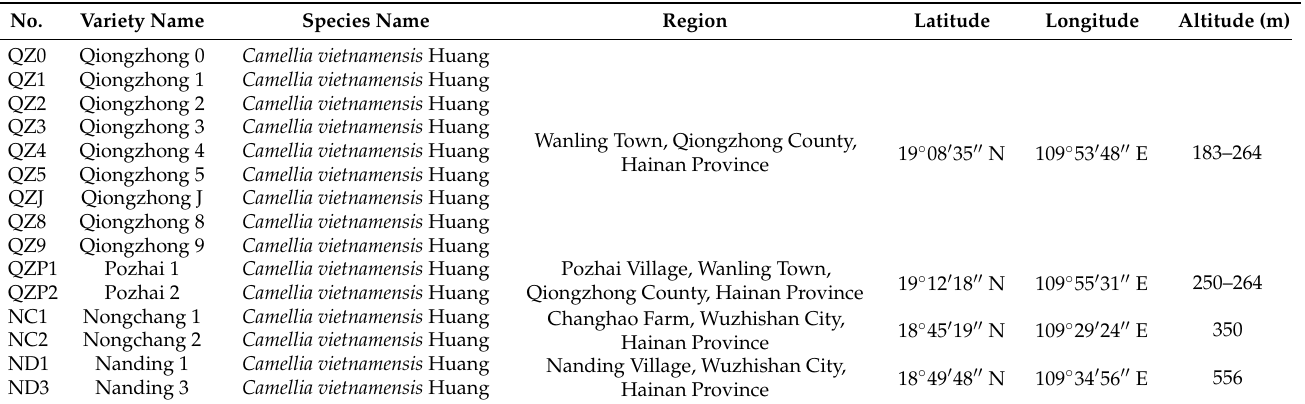
Table 1. Collection of Sample